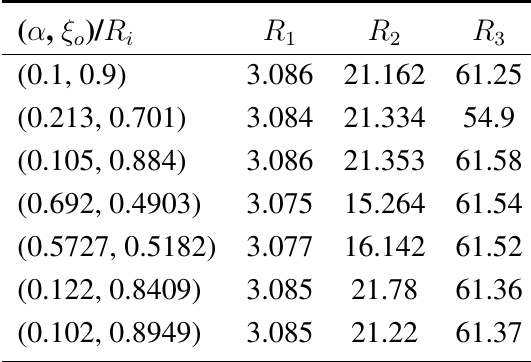
= 30 . 5 . The inset shows the two 21